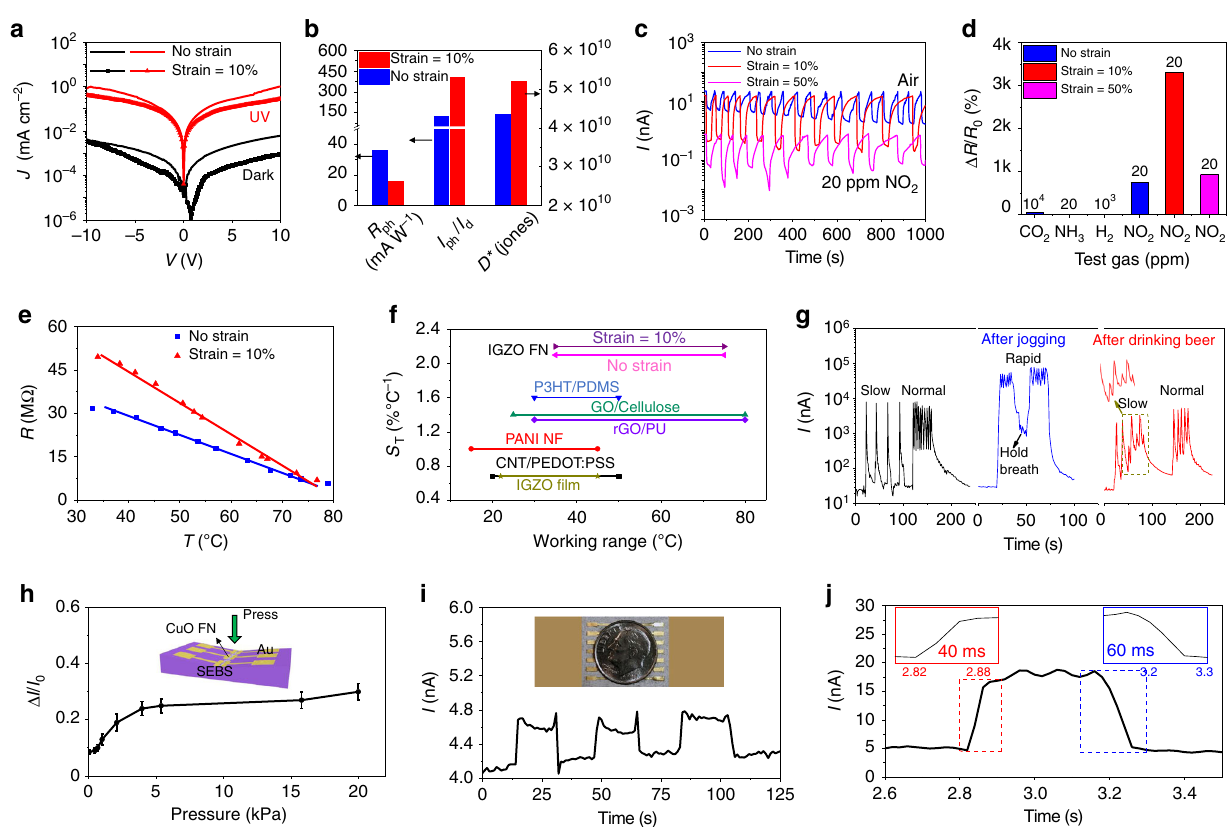
Fig. 4 Sensing performance for different types of FN-based resistors. a Normalized I – V curves of an IGZO FN/SEBS resistor (no strain and 10% strain) in the dark and upon UV exposure. b Calculated photoresponsivity, on/off current ratio, and resistor detectivity under no strain and 10% strain. c Cycling test for an IGZO FN/SEBS sensor exposed to 20 ppm NO 2 under no strain, 10%, and 50% strain (bias = 5 V). d Relative resistance changes of IGZO FN/SEBS sensor exposed to 20 ppm NH 3 , 20 ppm NO 2 , 1000 ppm H 2 , and 10,000ppm CO 2 . e Resistance change of IGZO FN/SEBS device over a 35 – 75 °C temperature range under no stain and 10% strain. f Comparison of temperature response sensitivity with literature reports. g Current change of a wearable resistor exposed to exhaled gas during respiration. Inset: enlarged I – t curves for slow breath rate after drinking alcohol. h Relative current of a CuO FN/ SEBS pressure sensor exposed to different pressures. Inset: schematic of a CuO FN/SEBS pressure sensor. i Dynamic I – t curve of pressure sensor by loading and unloading a dime covered by a piece of tape. Inset: schematic of a dime on CuO FN/SEBS pressure sensor. j Enlarged I – t curve when a fi nger contacts and disengages the sensor. Inset: enlarged plots show the response and recovery